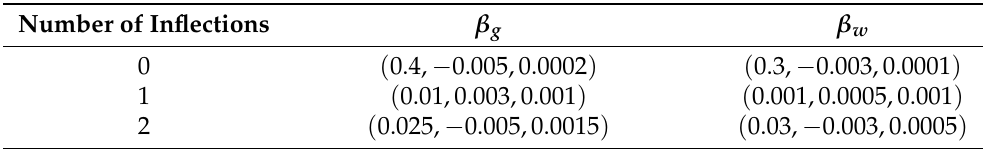
Table 1. Polynomial coefficients for examples in Figure 1. Number of